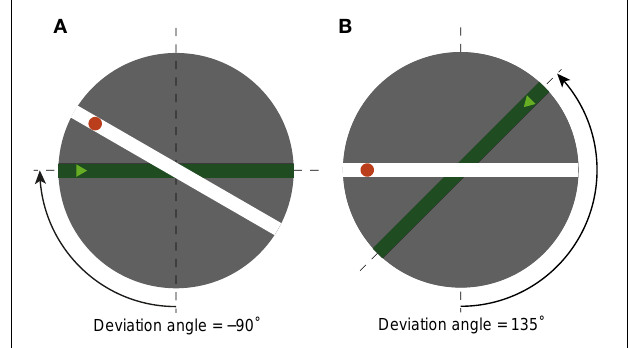
FIGURE 1 |Two examples of stimuli (the dashed lines, the angle arrow and text were not part of the stimuli). Every stimulus represents the crossing of two streets. Participants imagined being on the dark green street, at the position of the triangle, and facing the intersection.We call this orientation the imagined orientation .The task was to decide if at the intersection one should turn left or right in order to reach the red dot on the other street.We call the angle between the 6 o’clock (or upward-facing) direction and the imagined orientation the deviation angle . (A) An example stimulus with deviation angle of − 90˚. (B) An example stimulus with deviation angle of +